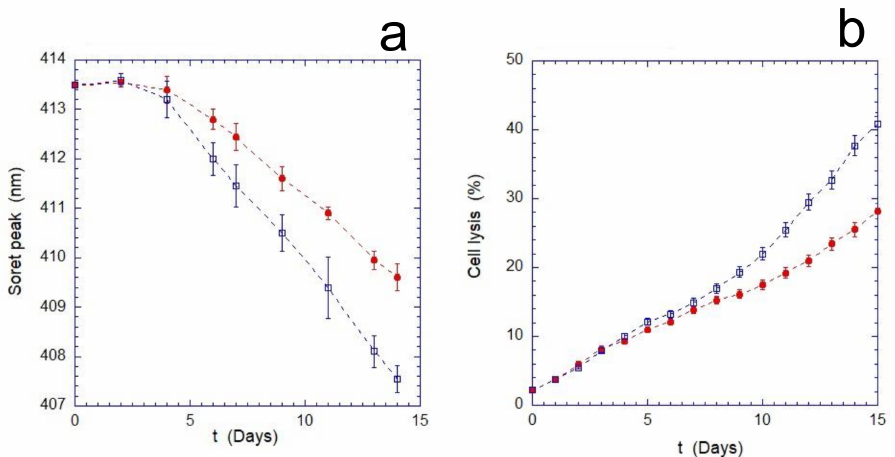
Figure 1. Percentage of cell lysis ( a ) and position of the Soret Peak ( b ) for static (red circles) and shaken (blue empty squares) samples. The overall stress experienced by the mechanically stimulated cells is higher with respect to the static ones at aging times, approximately, longer than 4 days.